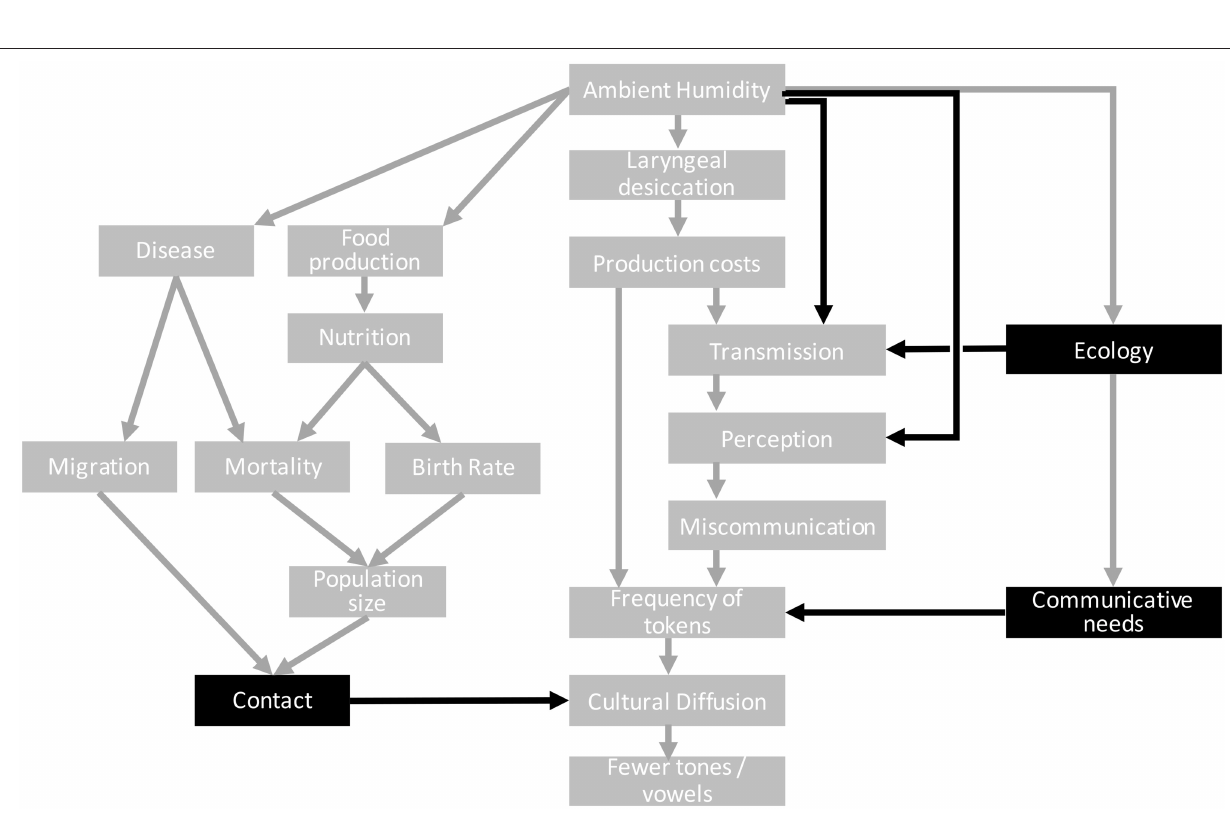
Frontiers in Psychology | www.frontiersin.org